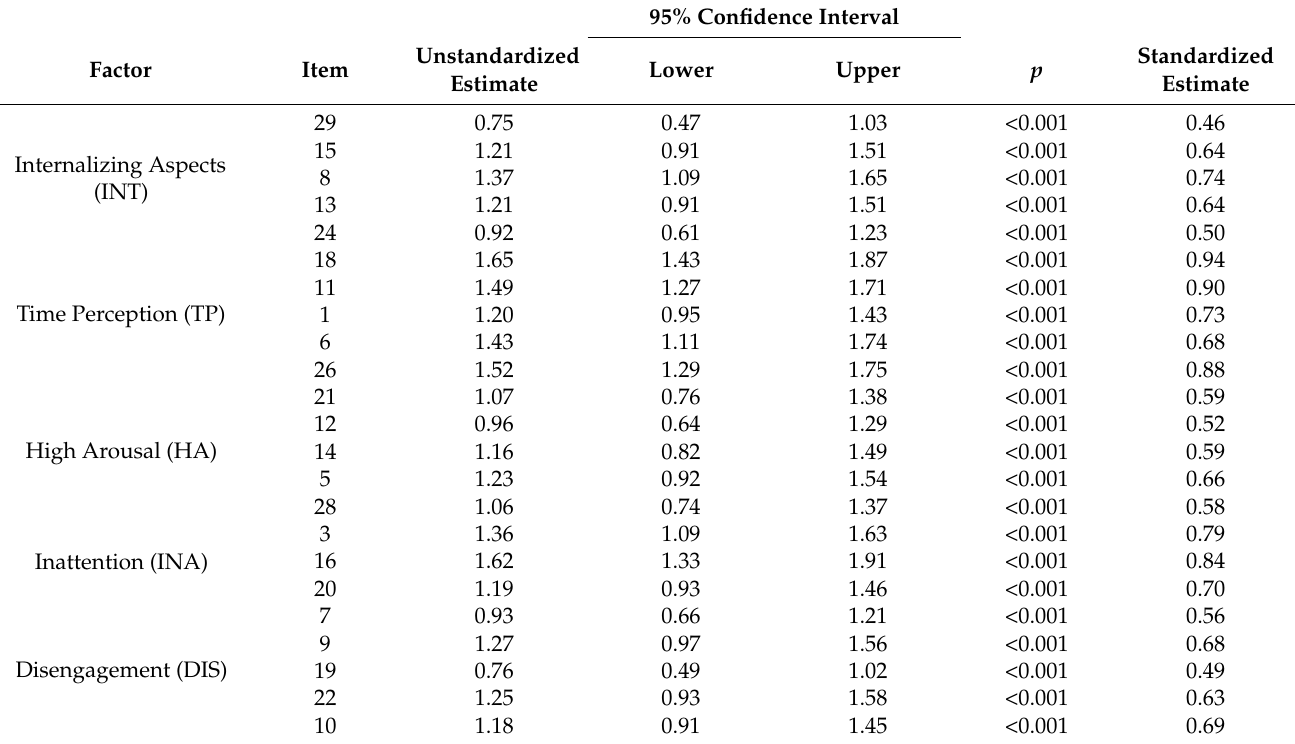
Table 5. Standardized and unstandardized saturations of items on their respective factors deriving from CFA of the final five-factor model of the